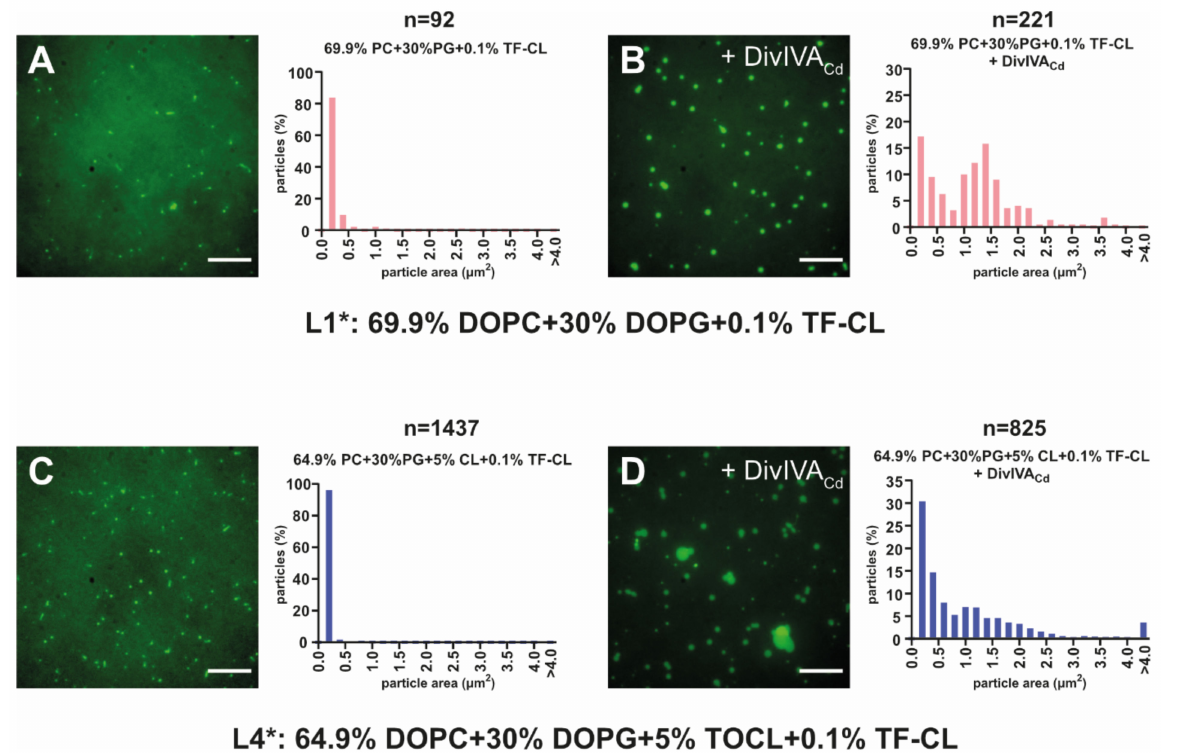
Figure 3. Changes to SLBs introduced by DivIVA Cd visualized using fluorescently labelled cardiolipin. ( A ) Representative image of SLB composed of 69.9% PC, 30%, PG and 0.1% TF-CL (L1*, the asterisk designates the presence of fluorescent TopFluor ® Cardiolipin) before the addition of DivIVA Cd . Most of the fluorescent signal was homogenously distributed, with only few brighter foci of TF-CL visible. ( B ) The addition of 2 µ M DivIVA Cd to L1* caused changes to the fluorescence distribution, resulting in TF-CL clustering. However, we did not observe clusters with areas larger than 4 µ m 2 . ( C ) SLB with 64.9% PC, 30% PG, 5% CL, and 0.1% TF-CL (L4*) before DivIVA Cd addition. ( D ) Adding DivIVA Cd to the chamber with an L4* SLB changed the lipid distribution and morphology of the bilayer even more visibly and larger clusters or foci can be observed (4% larger than 4 µ m 2 ). The scale bars represent 10 µ m. The bar charts show the distribution of fluorescent areas from several images analysed using the built-in “Analyse Particle” plugin for automatic particle counting in Fiji. The number of particles (n) detected and measured is given at the top of each